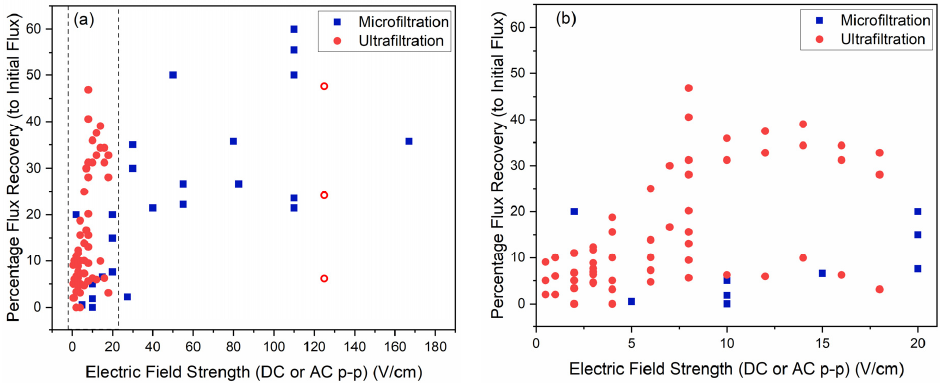
Figure 10. ( a ) Compilation of percentage permeate recovery vs. electric field strength. Results from DC field setups were indicated with solid symbols, and those from AC results were indicated with hollow symbols. ( b ) Magnified view of the region enclosed by the parallel dashed lines in ( a ). To date, most ultrafiltration experiments have used low-strength electric fields (<20 V/cm) and achieved higher flux recoveries. However, the electric field strength employed for microfiltration experiments were generally >20 V/cm and are more widely